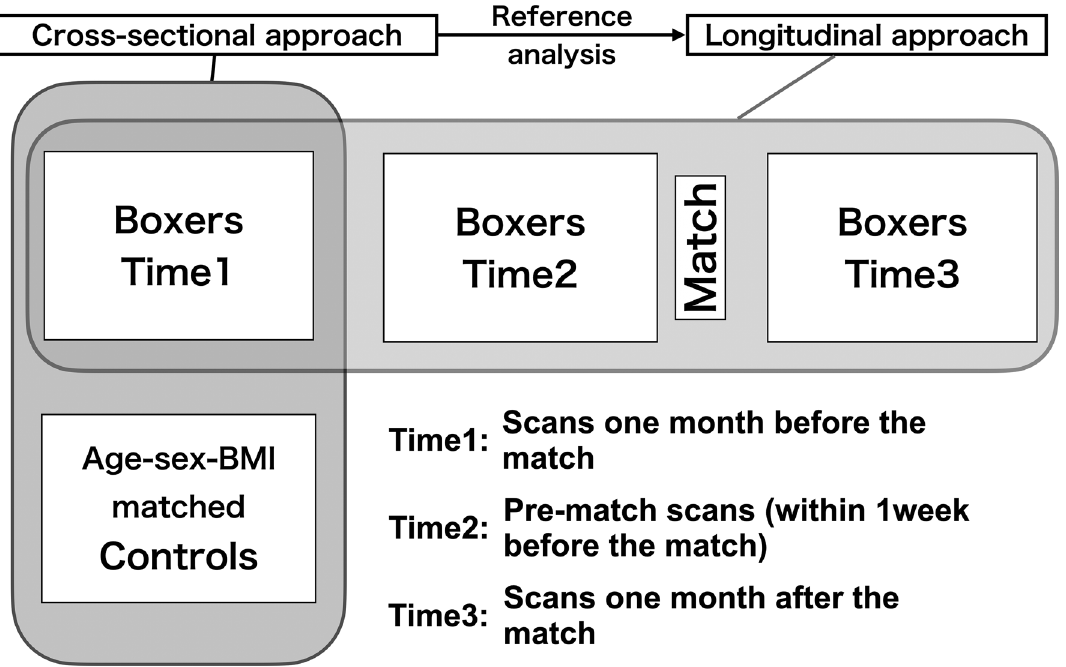
Figure 1. General design. We included 21 licensed male boxers and 22 age-, sex-, and BMI-matched controls. We followed up boxers at time points Time2 and Time3. All imaging statistical thresholds for VBM and rs-fMRI were set to uncorrected p < 0.001 at the voxel level, and FWE-corrected p < 0.05, at the cluster level. FWE, family- wise error; rs-fMRI, resting-state functional magnetic resonance imaging; VBM, voxel-based